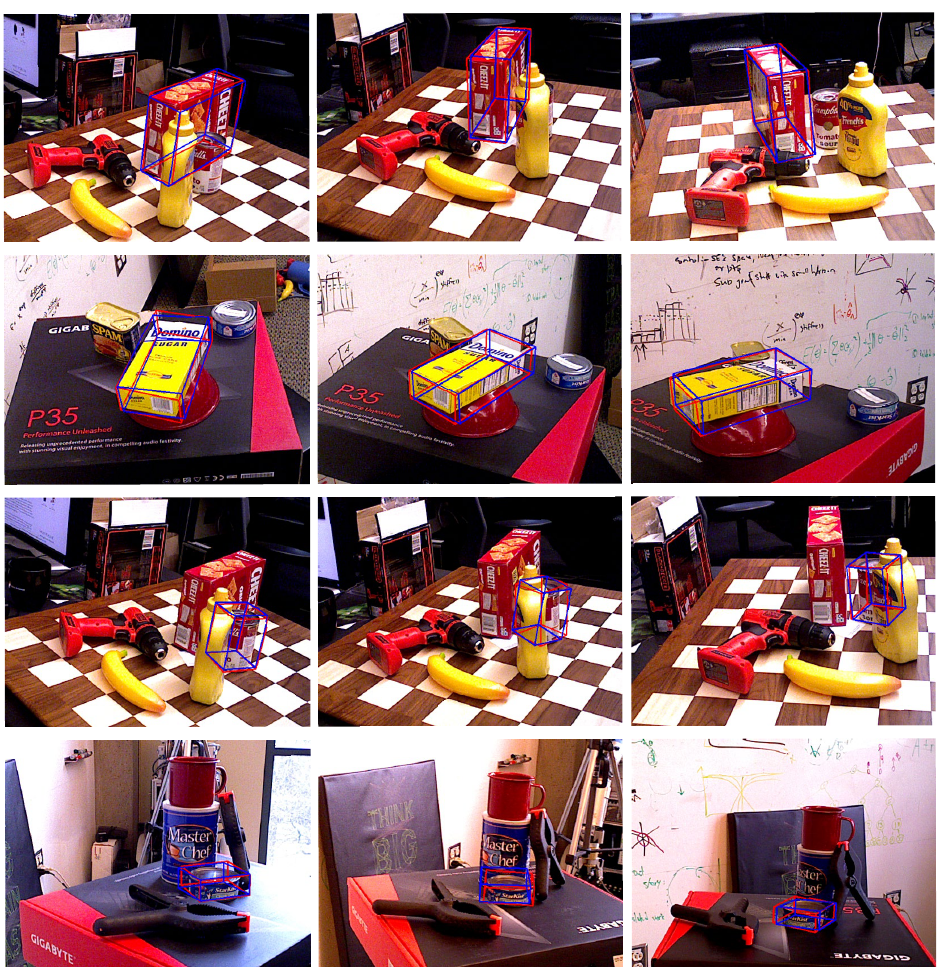
Figure 10. Estimated 6D pose on YCB-Video dataset [19]. The ground truth is shown in red, and estimated results with DeepHMap++ are shown in blue. The four rows (from up to down) correspond to test images from 003_cracker_box sequence, 004_sugar_box sequence, 005_tomato_soup_can sequence and 007_tuna_fish_can sequence,